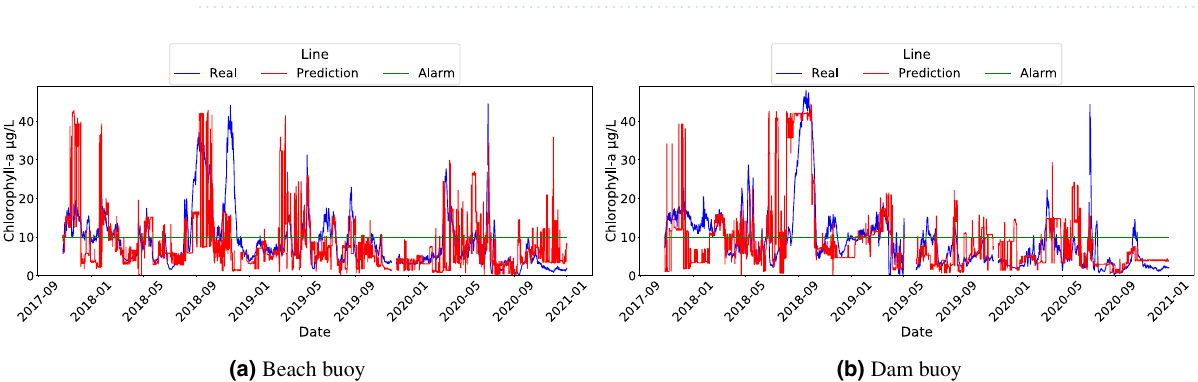
Figure 10. Comparison of various input aggregation and output aggregation methods using CART: Beach buoy in terms of MAE ( a ); Dam buoy in terms of MAE ( b ); Beach buoy in terms of F1 ( c ); Dam buoy in terms of F1 ( d ).